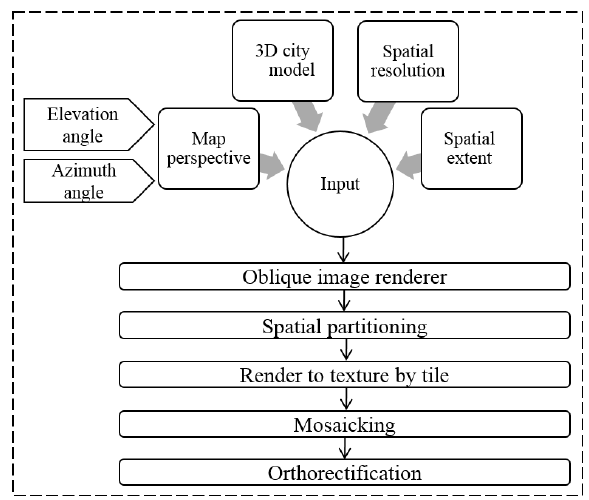
Figure 3. A framework for producing orthorectified 2.5D maps from massive 3D city models.